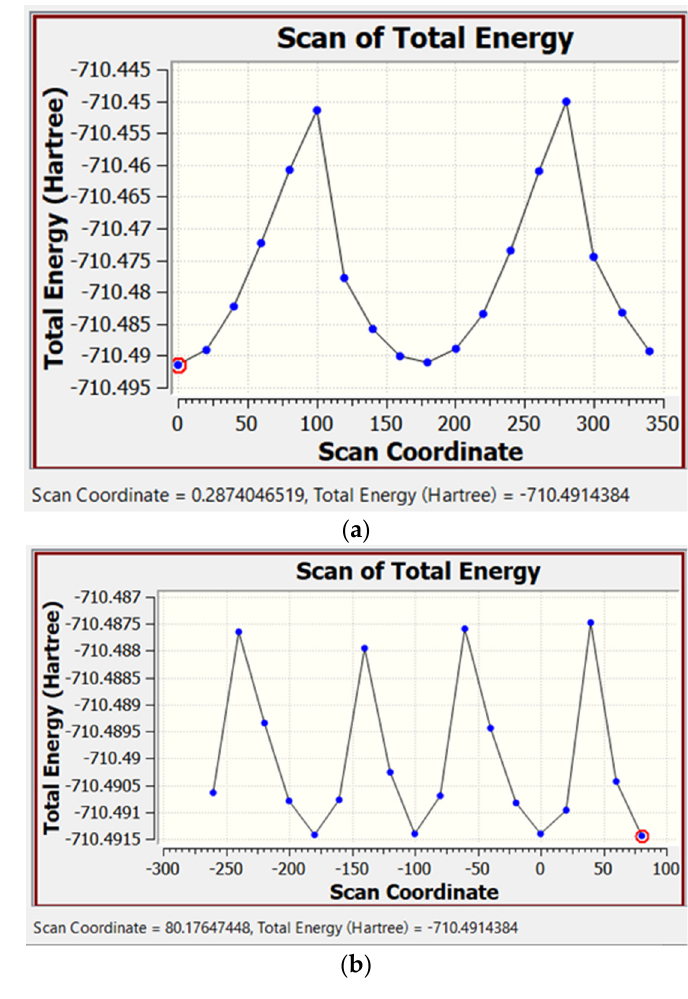
Figure 5. The energy profiles obtained by one-dimensional relaxed scanning the PES of BHFA-NMe on variation of the torsion angles O=C-N-CH ( a ) or N-CH-C Ar =C Ar ( b ) with a step of 20°. At each step, the remaining geometric parameters of the molecule were completely optimized in the M06-2X/6-311+G*/IEFPCM(DMSO) approximation.